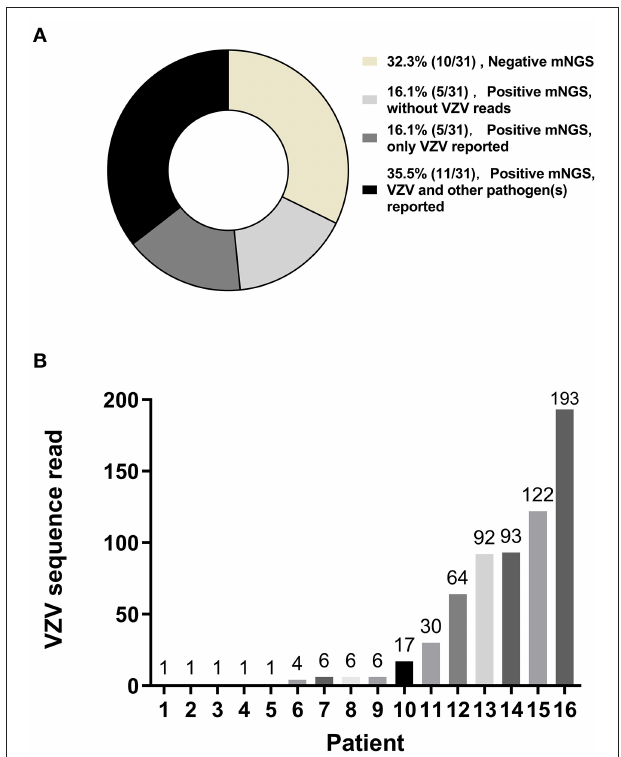
FIGURE 1 | Metagenomic next-generation sequencing (mNGS) of cerebrospinal fluid (CSF) samples. Metagenomic next-generation sequencing was performed on CSF samples from 31 patients with suspected varicella-zoster virus (VZV) central nervous system (CNS) infections. VZV sequence reads were the only sequence reads reported in 16.1% (5/31) of the patients. VZV sequence reads and sequences reads of other pathogens were both reported in 35.5% (11/31) of the patients (A) . Of those 16 patients with VZV being detected by CSF mNGS, variable numbers of VZV sequence reads were reported (B)